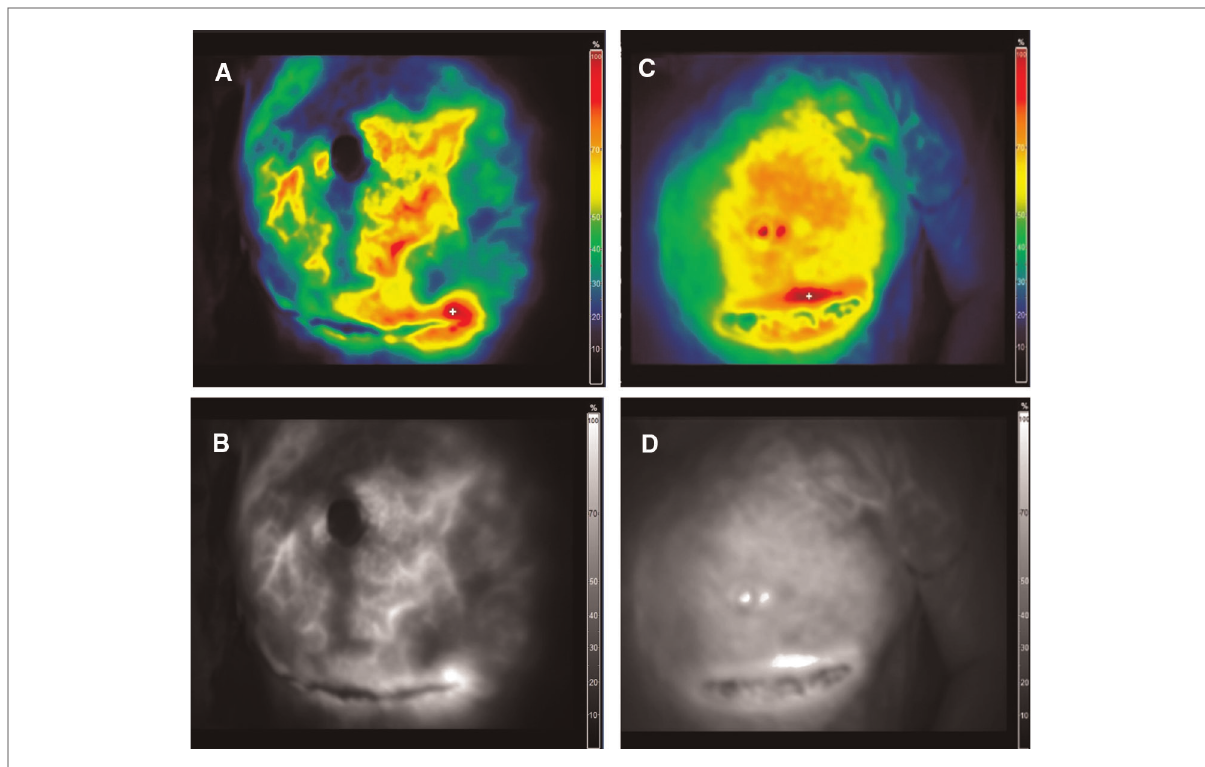
FIGURE 5 Intraoperative ICG angiography of mastectomy fl ap. ( A,B ) Color mode and fl uorescence angiography of mastectomy fl ap after c-NSM. ( C,D ) Color mode and fl uorescence angiography of mastectomy fl ap after m-NSM. ICG-indocyanine